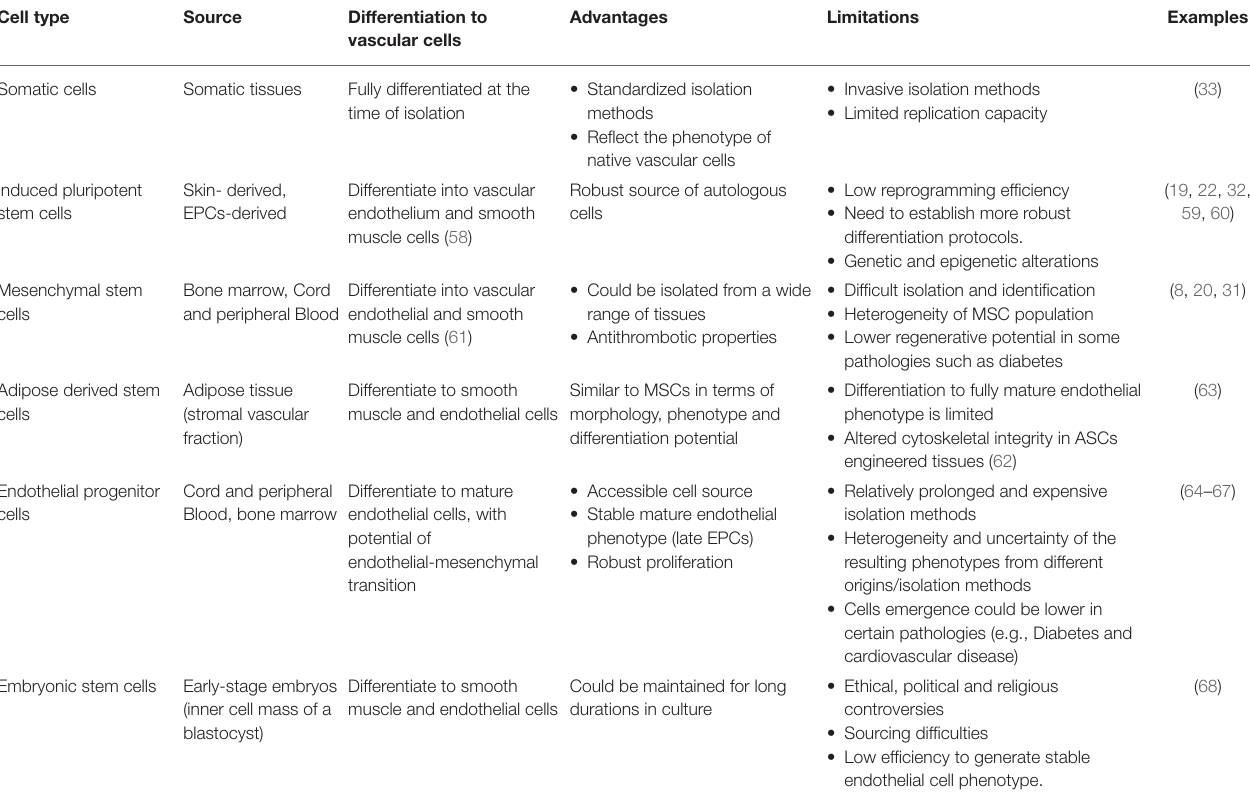
TABLE 3 | Summary of the cell sources for vascular tissue engineering, their advantages, and